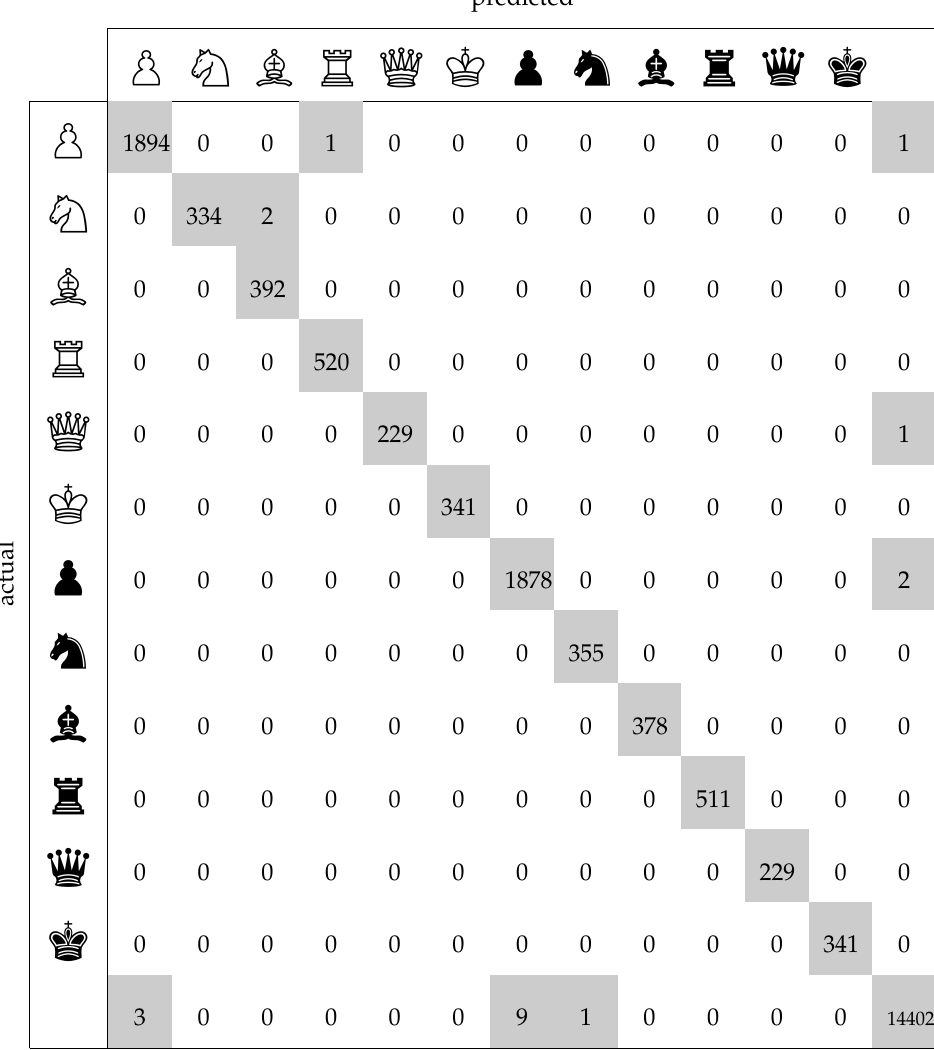
Figure 11. Confusion matrix of the per-square predictions on the test set. Non-zero entries are highlighted in grey. The final row/column represents empty squares. Chessboard samples whose corners were not detected correctly are ignored